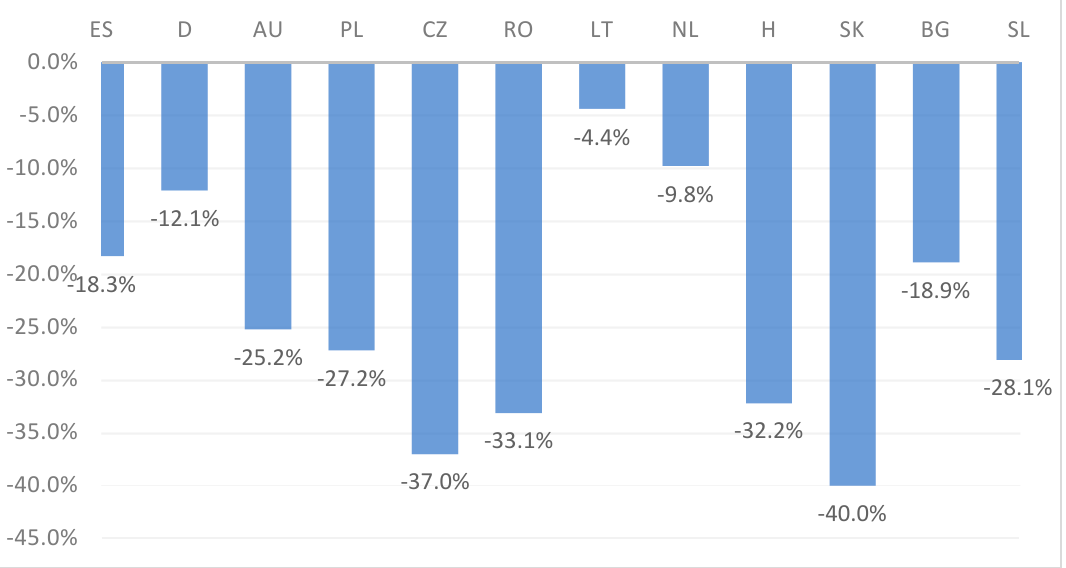
Figure 1. Declines in the traffic of international road carriers’ vehicles (by country) registered in Germany (April 2019–April 2020) [1].